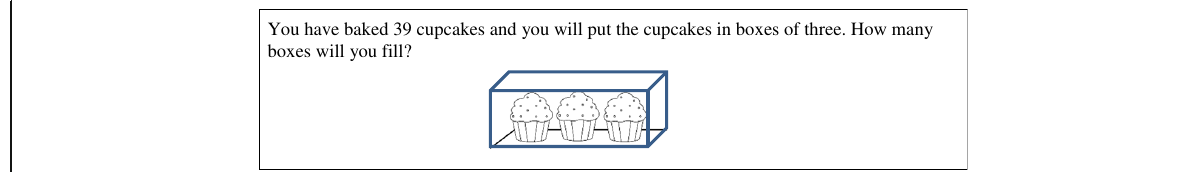
Fig. 1 Cupcake Task A (For this task and all other tasks in this study involving cupcakes, the cupcake image is used courtesy of MyCuteGraphics.com © Laura Strickland)